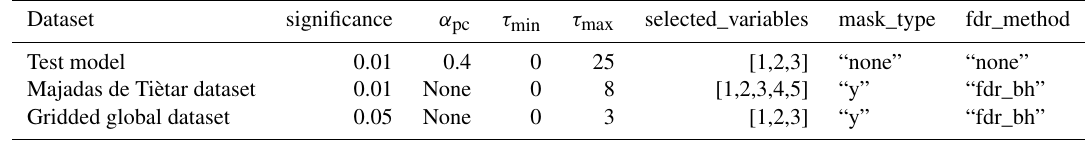
Table A1. PCMCI parameters that were used differently from default settings.